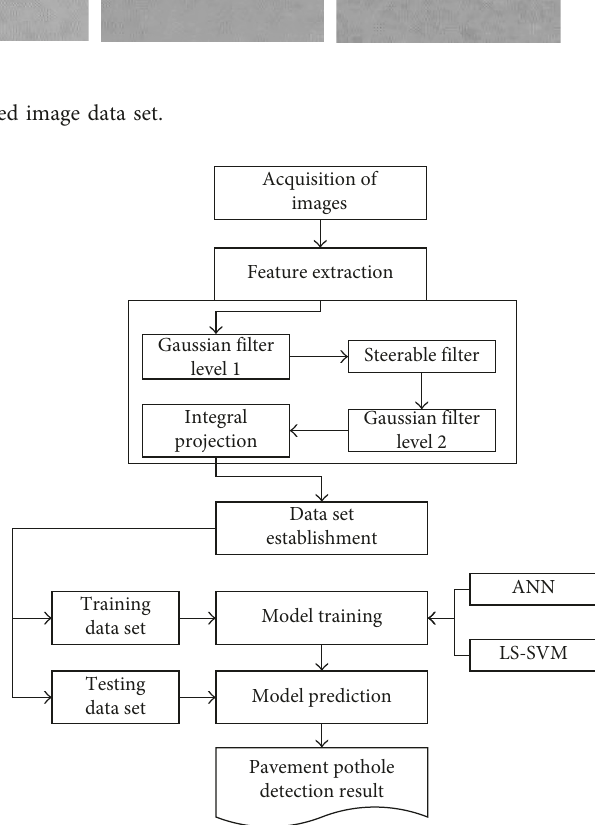
Figure 7: The proposed pavement pothole detection model